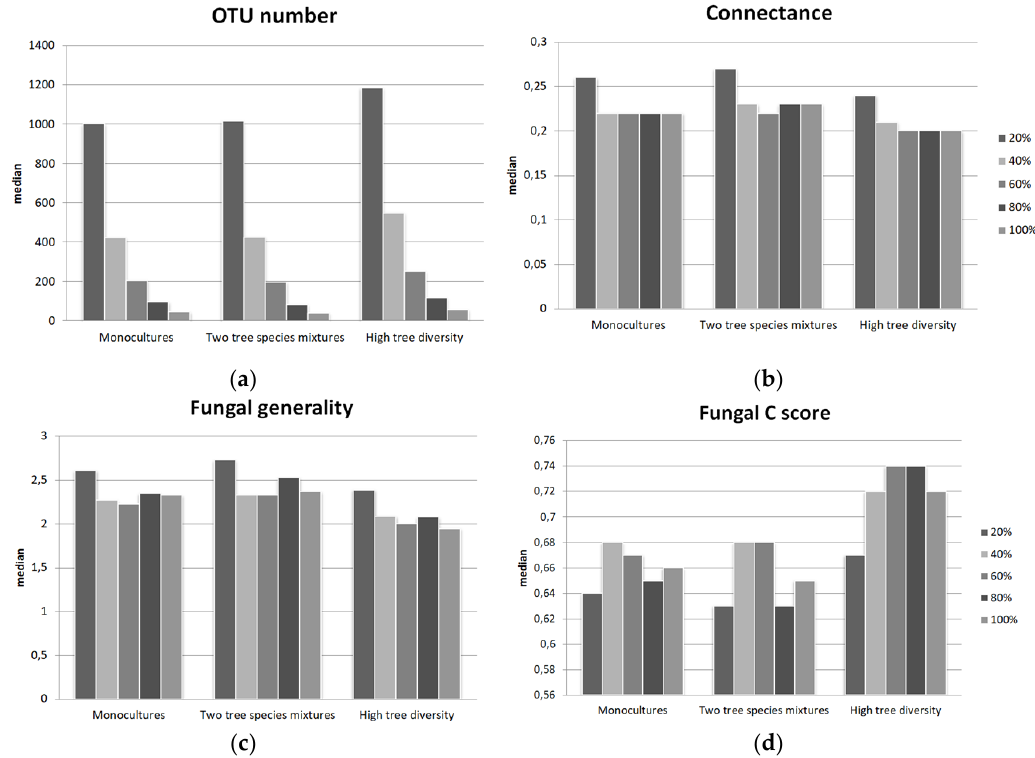
Figure 2. Dependence of the calculated network characteristics on the link threshold for tree species – fungal OTU co-occurrence in the bipartite network analysis. The charts show the median values (based on 576 subsamples) of four key network characteristics: fungal OTU number ( a ), network connectance ( b ), fungal generality ( c ) and fungal C score ( d ). A table showing all of the computed network characteristics is available in the Supplementary Material (Table S1). Table 1. Calculated network metrics for different levels of tree species diversity based on 576 tree- fungal bipartite subsamples and three tree diversity levels: monocultures (“Mono”) , two-tree species mixtures (“Two mix.”) and high tree diversity mixtures (“High”) . The Kruskal-Wallis test was used to identify significant differences in network values across the tree diversity levels. The median values of the network characteristics are reported for each tree diversity level. The Kruskal-Wallis test for multiple comparisons with the Bonferroni-Holmes correction was used to assess the significance of pairwise differences in network characteristics across tree diversity levels (n.s.: no significant difference detected). Numbers indicate the tree diversity levels: 1-monocultures, 2-two tree species